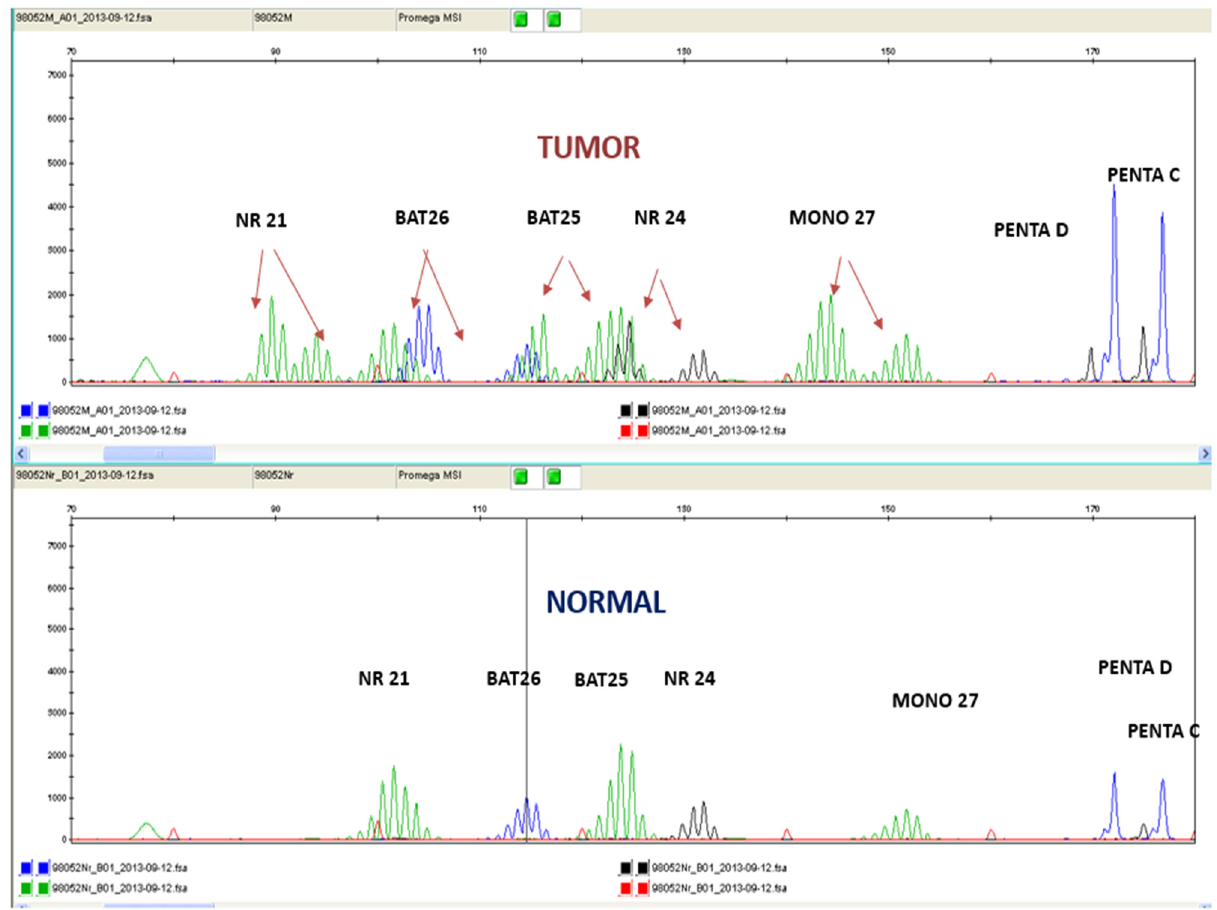
Figure 2. Electropherogram using the pentaplex panel comparing normal tissue samples (bottom panel) with tumor tissue samples (top panel) of the same patient. The additional peaks present on the top panel are a result of MSI. Red arrows indicate microsatellite instability.